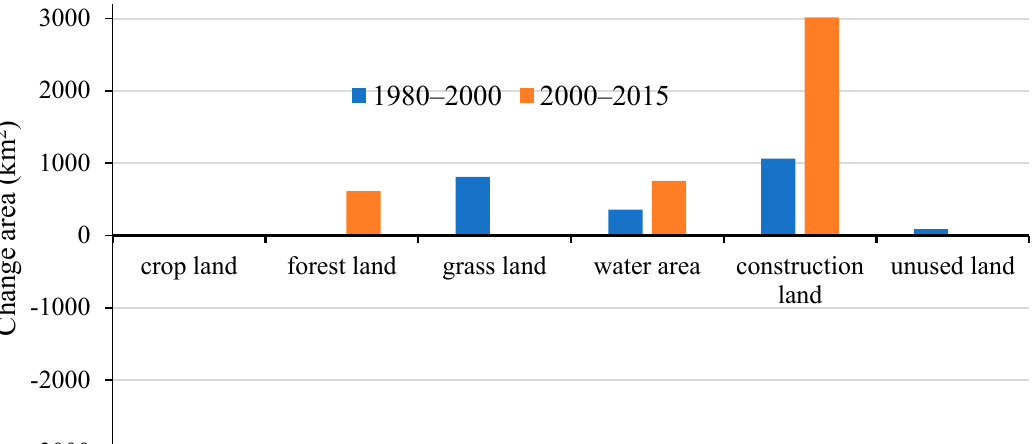
Figure 10. Spatial distribution of land use and cover change in the karst areas of Southwest China in 1980, 2000, and 2015.